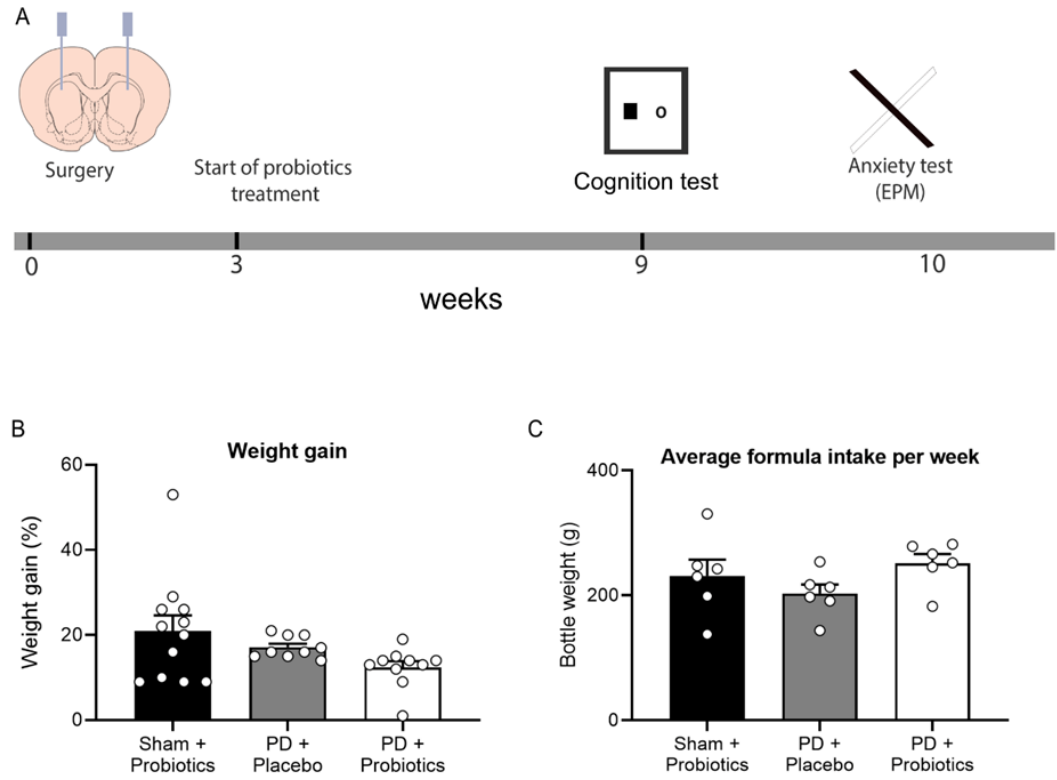
Figure 1. ( A ) Timeline of experimental procedures. Rats received intracranial surgery to deliver saline or 6-OHDA into the striatum. Three weeks post-surgery, placebo / probiotics formula was given to rats in their home cages. After six weeks of formula treatment (9 weeks post-surgery), behavioural assessments began. ( B ) Graph of percentage of weight gain during 6 weeks of formula treatment. No group di ff erences between groups, p = 0.08. ( C ) Graph of average formula intake per week during 6 weeks of formula treatment, no group di ff erences between groups, p = 0.235.